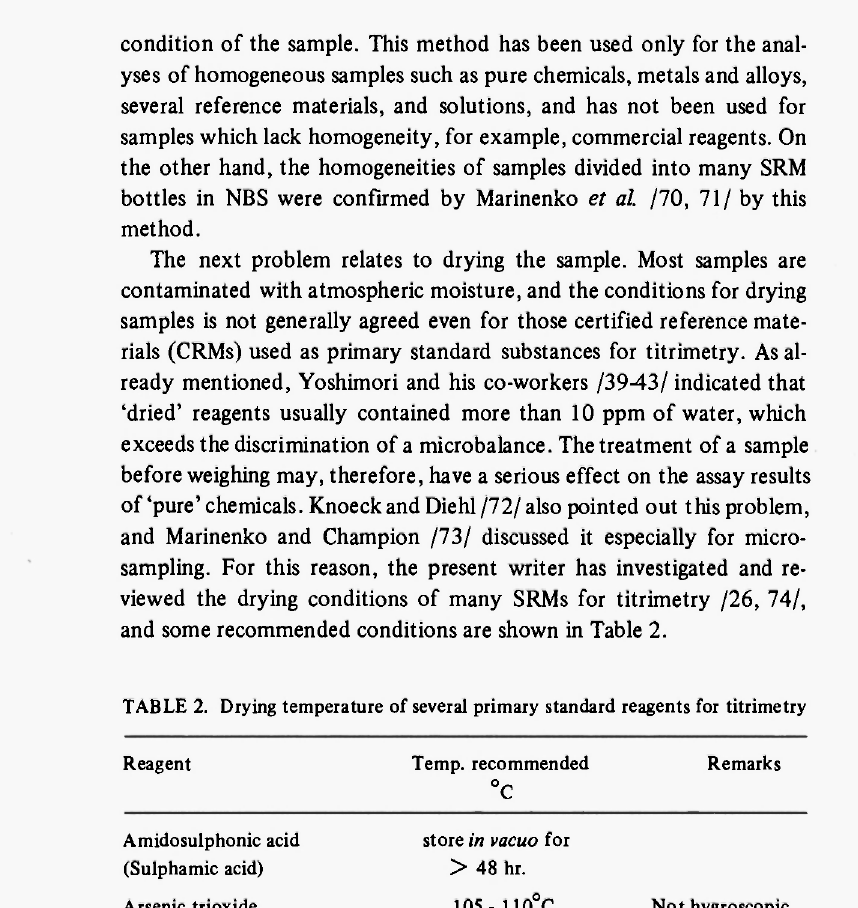
TABLE 2. Drying temperature of several primary standard reagents for titrimetry Reagent Temp,